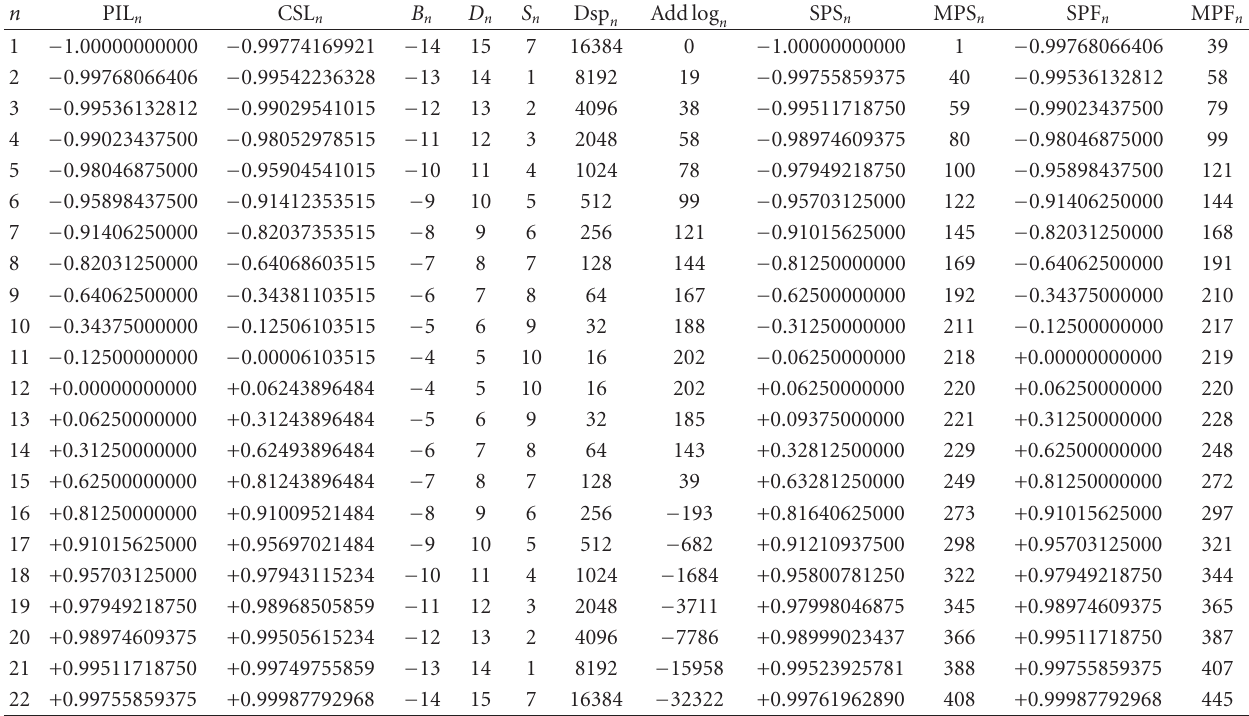
Table 2: Configuration parameters calculated for sampling scheme α .